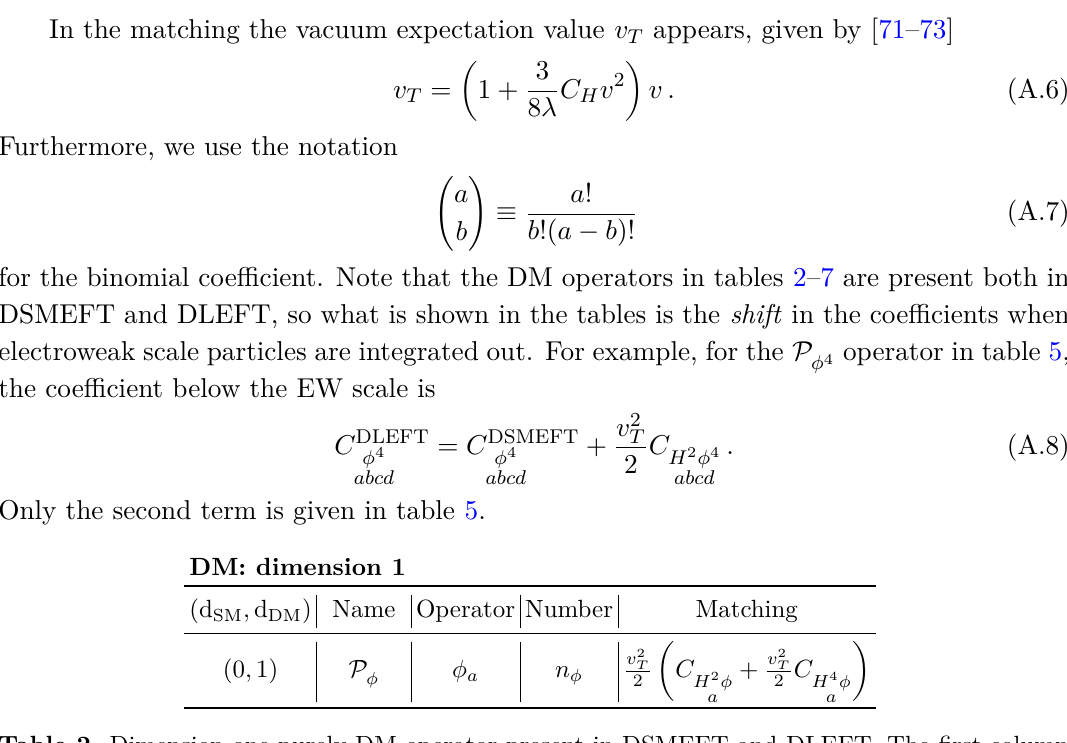
Table 2 . Dimension-one purely DM operator present in DSMEFT and DLEFT. The first column gives the dimensions of the SM and DM part of the operator, the fourth column is the number of operators, and the fifth column is the additional matching contribution at the EW scale.